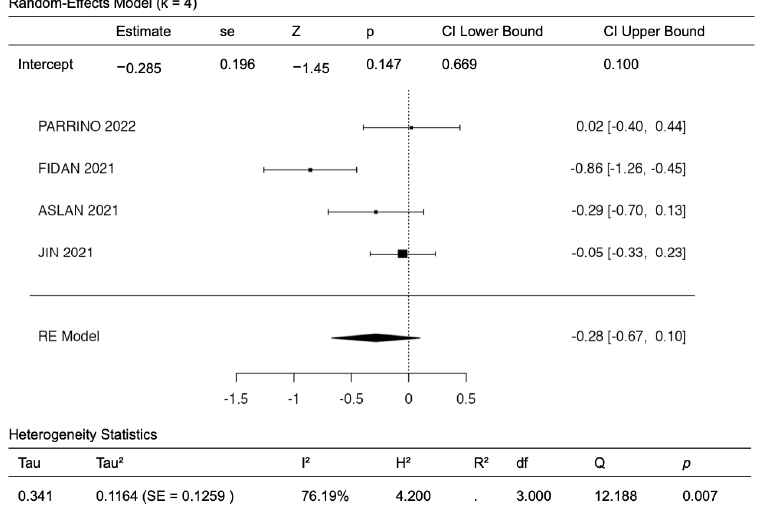
Figure 2. Forest plot showing mean differences in age of onset of SSNHL patients at single institutions in the pandemic year period vs. pre-pandemic year period.